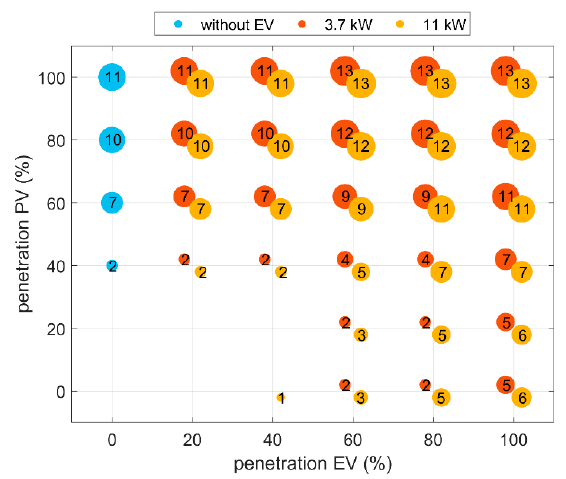
Figure 11. Number of overloaded lines of the 5 kV voltage level for charging strategy 1.